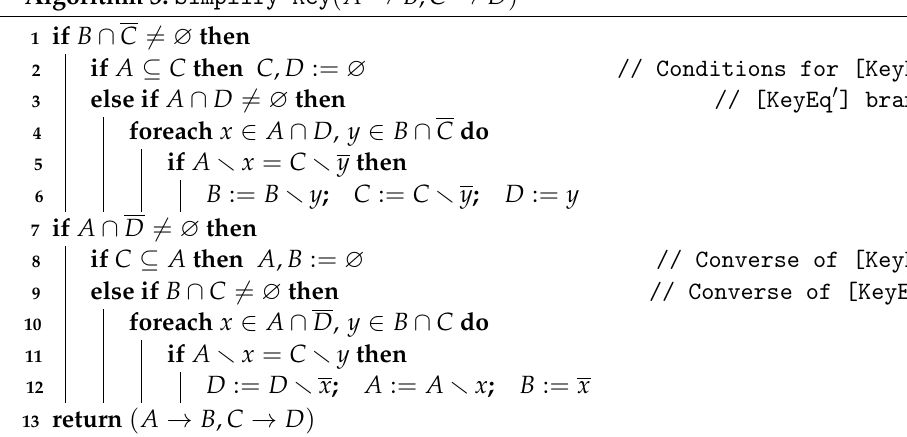
Algorithm 3: Simplify-Key ( A